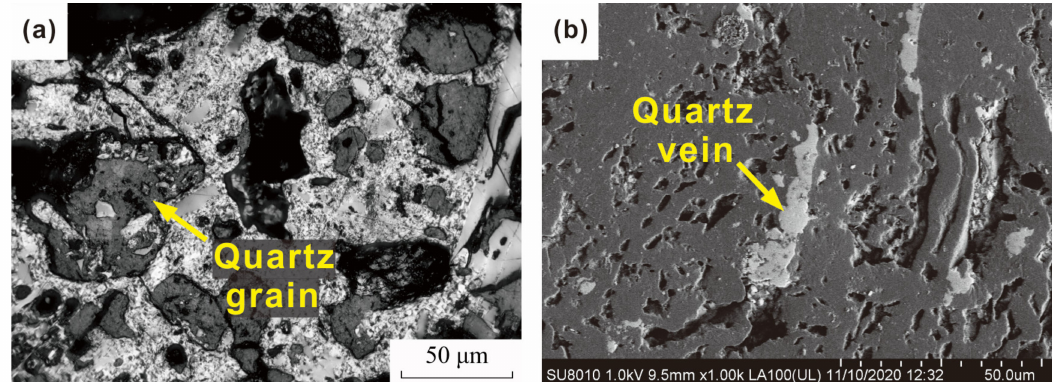
Figure 8. Epigenetic quartz in the thermally altered Tashan coal: ( a ) quartz grain filling in vacuoles, white reflected light, and immersion oil under the optical microscope; ( b ) quartz vein filling in fissures, SEM backscattered electron images.